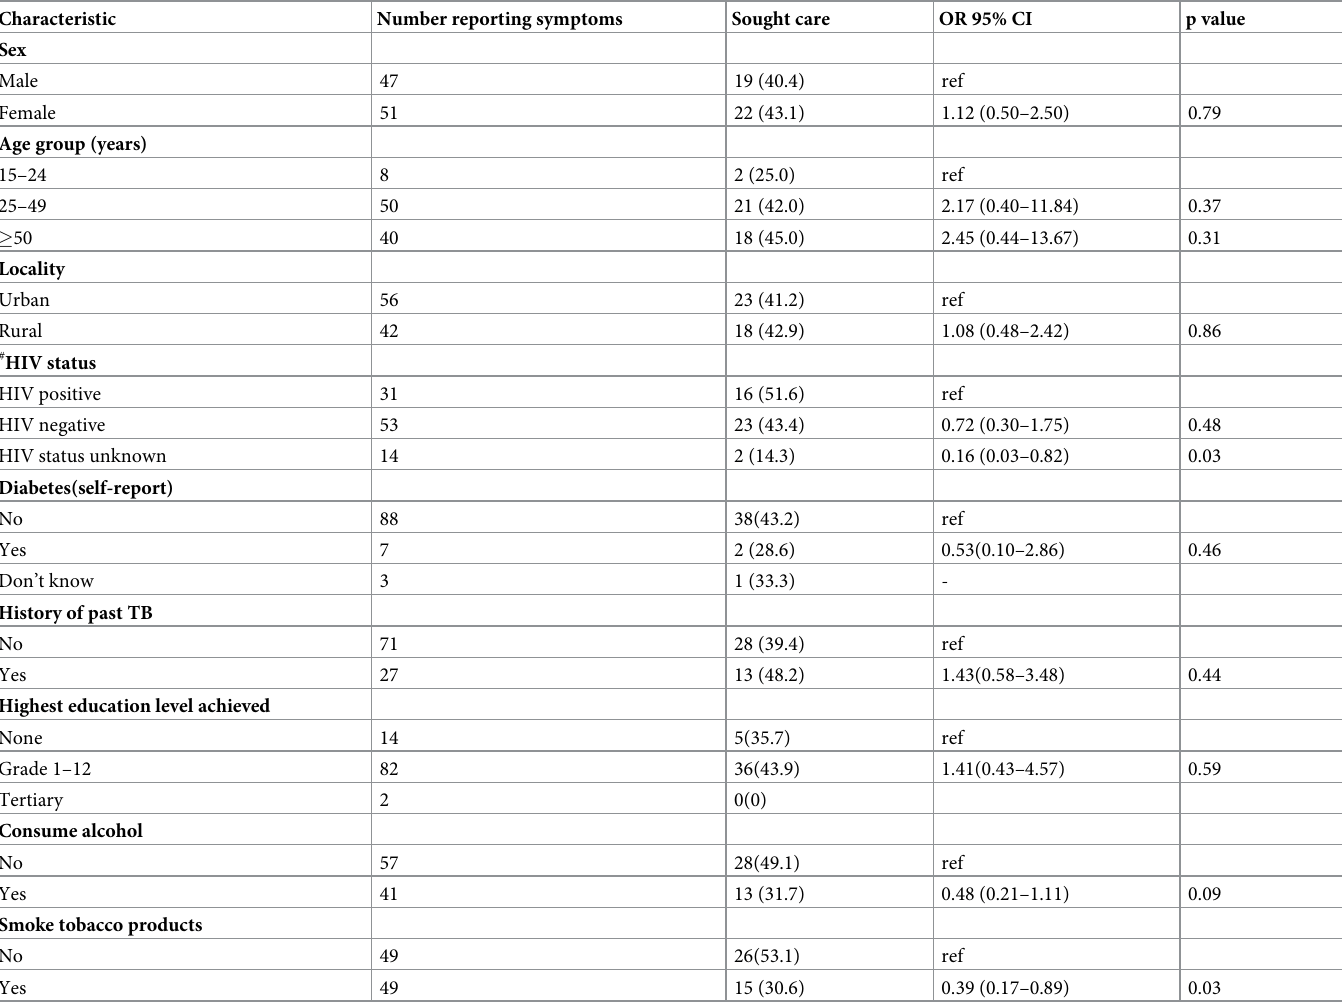
Table 3. Factors associated with self-reported care seeking for TB symptoms in participants with bacteriologically confirmed TB in a community survey, n = 98.